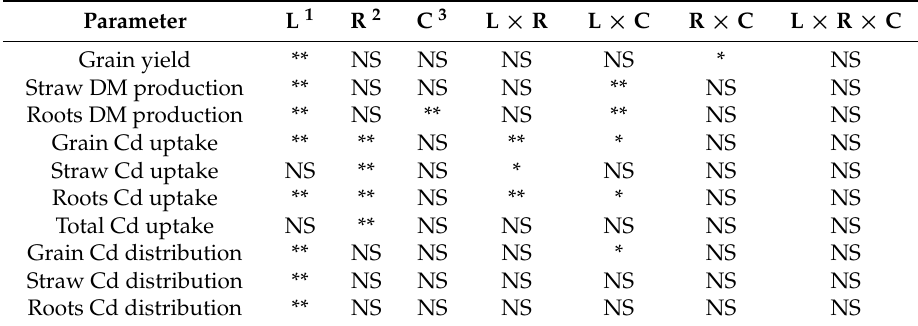
Table 3. Significance levels of the evaluated parameters for the experiments in three corn cultivars fertilized with three CdCl 2 rates on three environments.